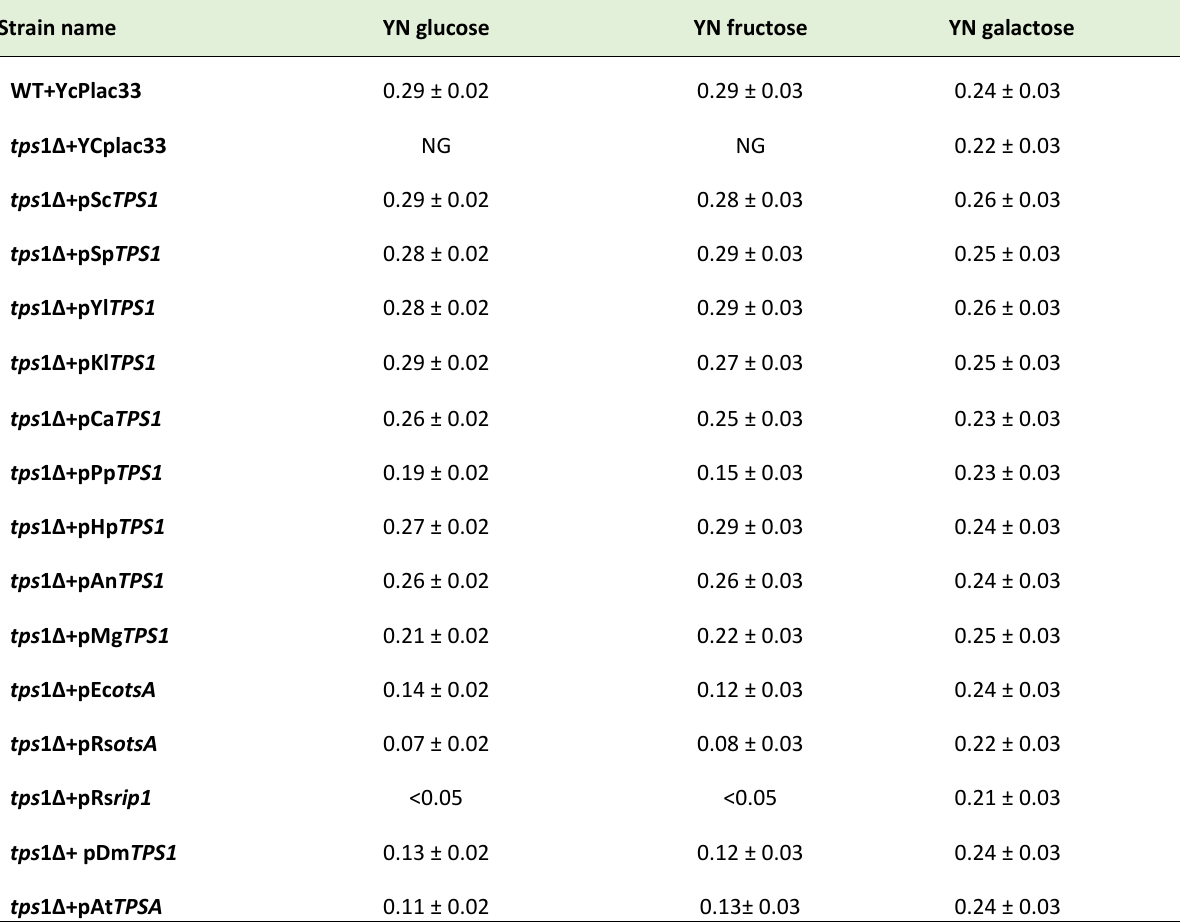
TABLE 1 . Growth rate of S.cerevisiae tps1 mutant transformed with TPS1 from various origin in microplate on different carbon